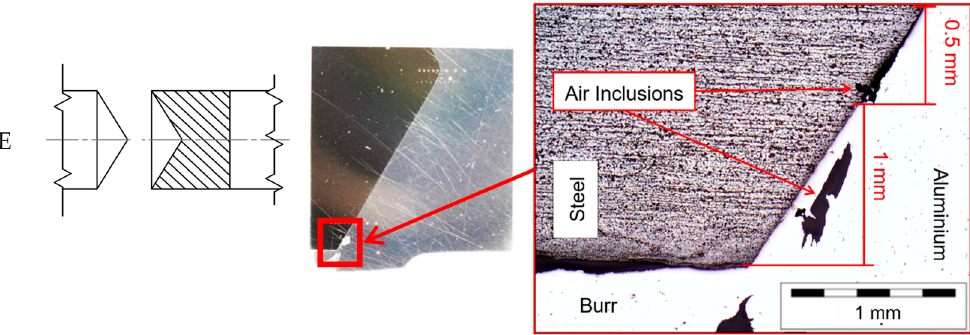
Figure 9. Geometry E, ( left ) schematic draft, ( middle ) overview of a half-cut sample, and ( right ) example of air inclusions in regions of the increased diameter.